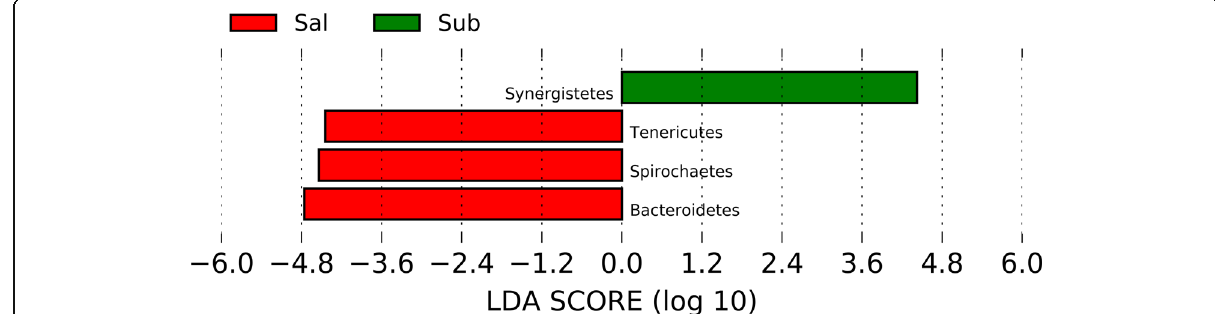
Fig. 5 LEfSe results of oral samples identified bacterial phyla enriched in salivary (SAL) and subgingival (SUB) plaque of healthy adult dogs.